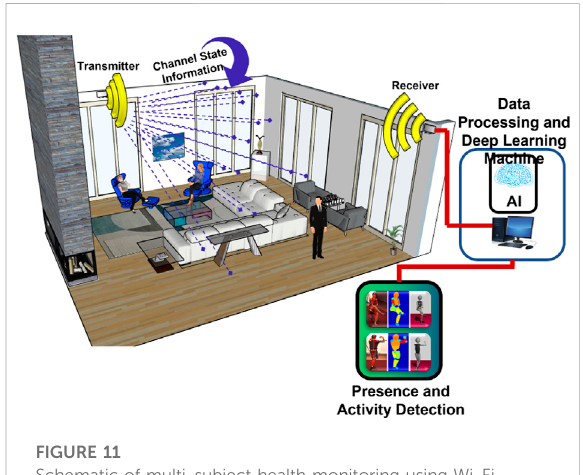
FIGURE 11 Schematic of multi-subject health monitoring using Wi-Fi signals (Ashleibta et al., 2021b).